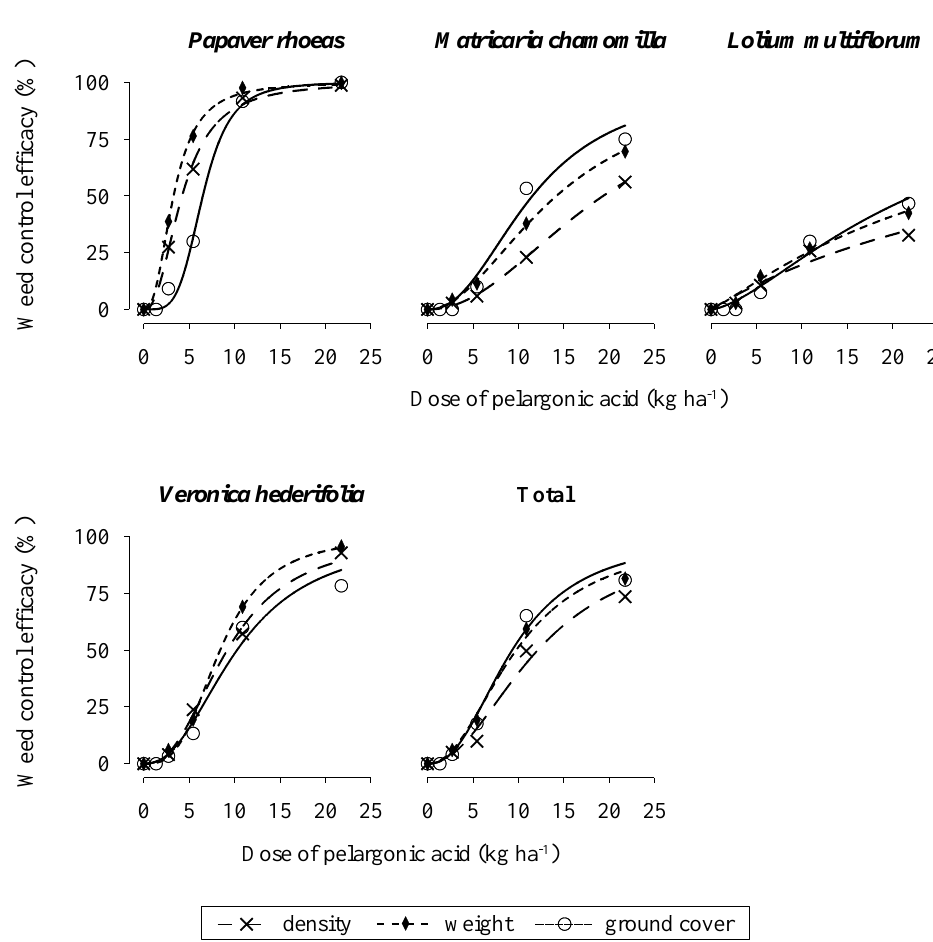
Figure 2. Dose-response curves for the efficacy of pelargonic acid against winter weed species based on their density, weight, and ground cover data. Symbols show observed data and lines show fitted curves according to Model [2].